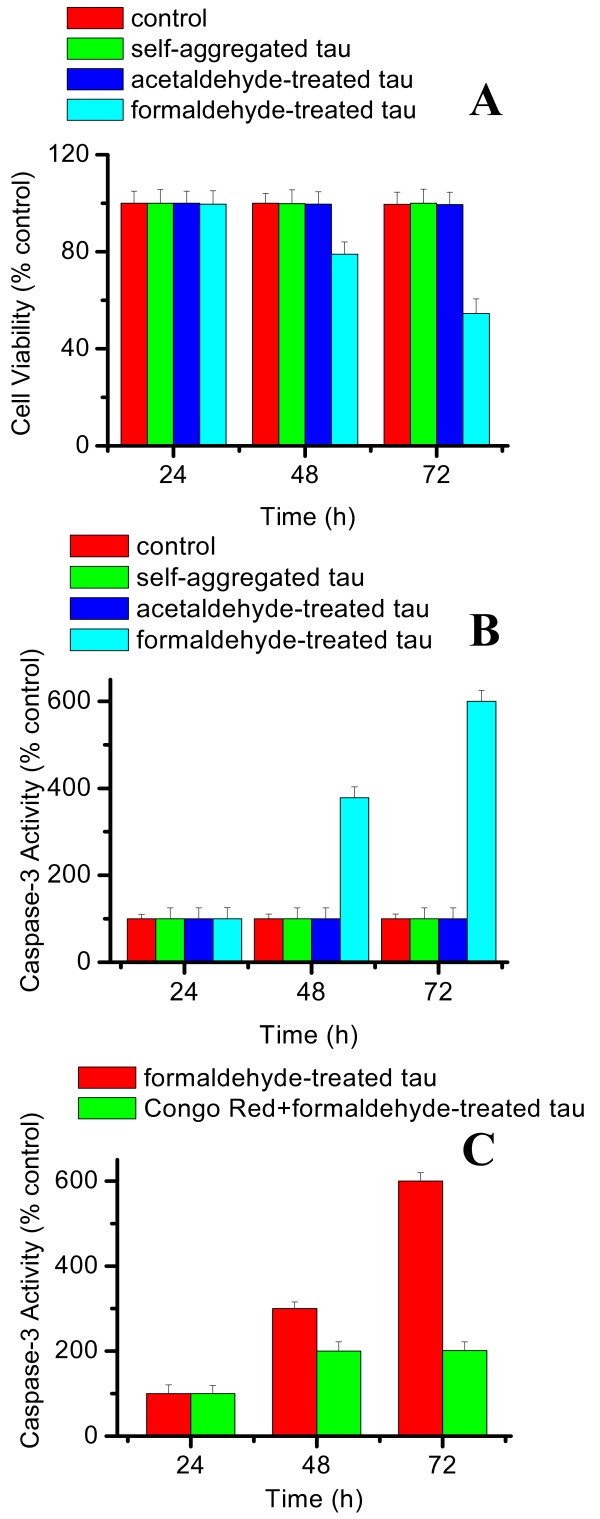
Cell viability and Caspase-3 activity measurements over time. (A) Cell viability was measured by the MTT assay as described in Materials and methods. (B) After SY5Y cells were treated with different tau samples (2 μM) for 24 h, cell lysates were collected at the times indicated and used to measure caspase-3 activity. (C) SH-SY5Y cells were treated with tau deposits (2 μM) in the presence or absence of 10 μM Congo red. Cell lysates were collected at the times indicated and caspase-3 activity was measured. Data are expressed as a percent of the control (cells treated with vehicle alone) and presented as the mean ± SEM (n = 6).